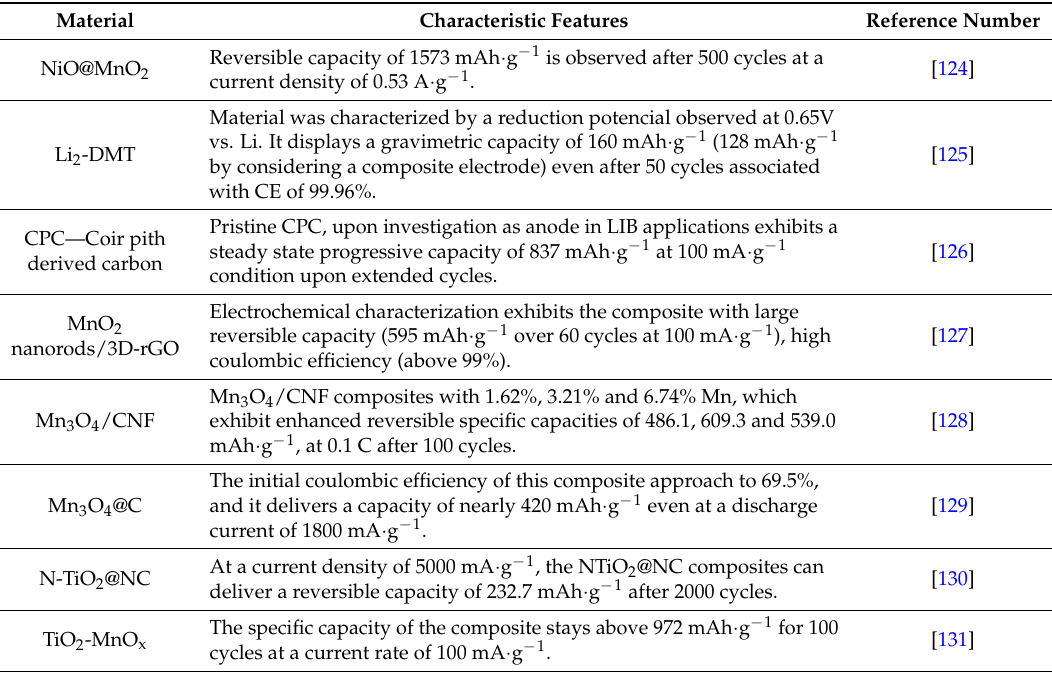
Table 7. Example of a functional anode